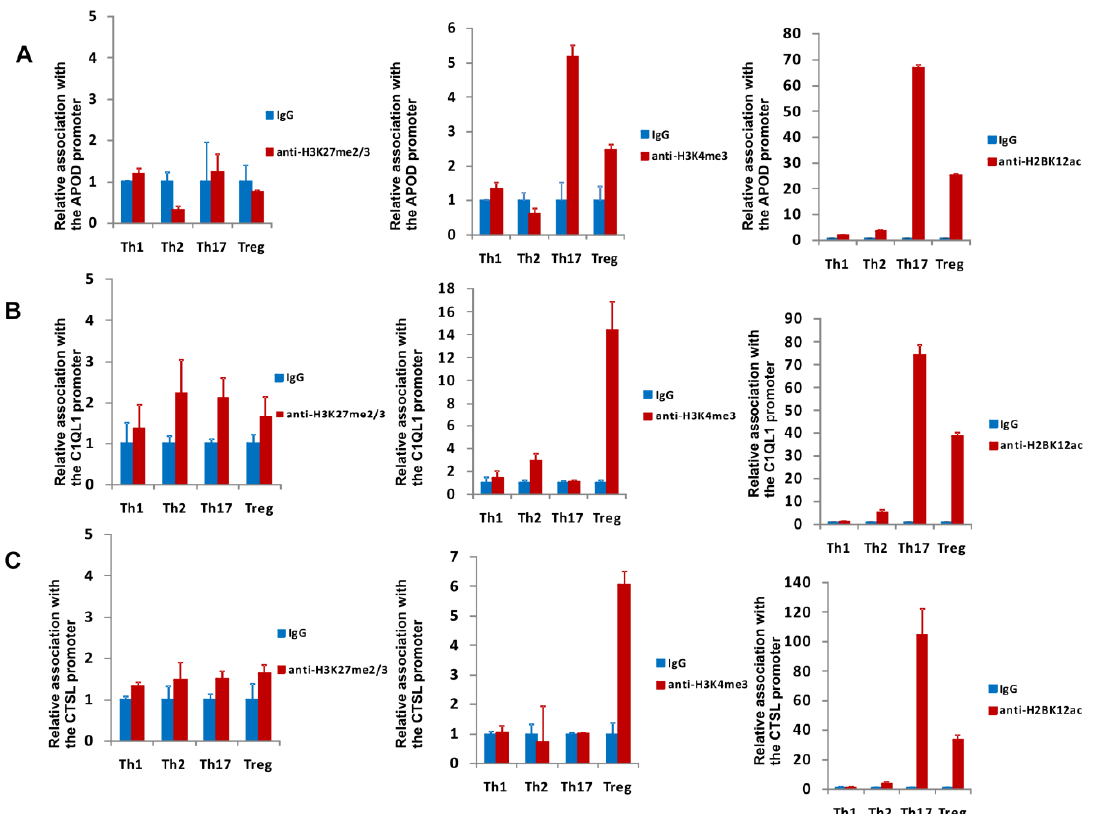
Figure 4. Analysis of the binding of H3K27me2/3, H3K4me3, and H2BK12ac in vivo to the promoter sequences of the APOD ( A ), C1QL1 ( B ), and CTSL ( C ) genes in Th1, Th2, Th17, and Treg cells by chromatin immunoprecipitation. The results are shown as the mean ± SD, n = 3 (different donors).